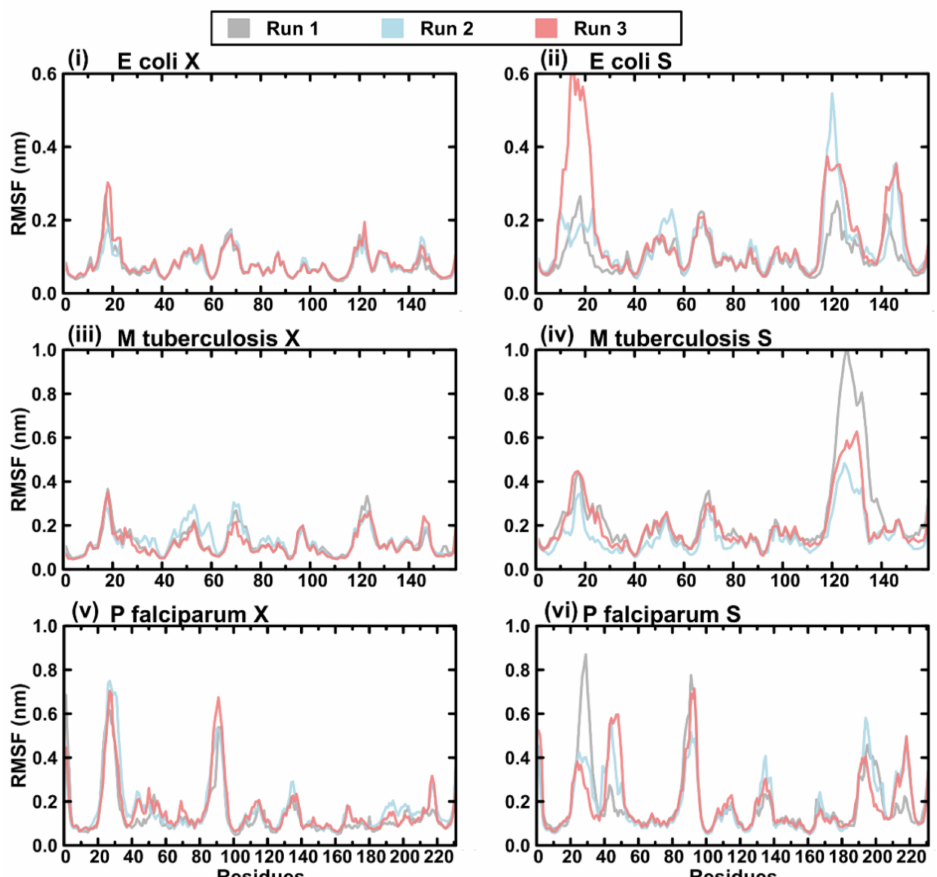
Figure 9. Plots of protein RMSF for the triplicate MD runs: ( i ) the crystal structure models of E. coli , ( ii ) the separated loop models of E. coli , ( iii ) the crystal structure models of M. tuberculosis , ( iv ) the separated loop models of M. tuberculosis , ( v ) the crystal structure models of P. falciparum , and ( vi ) the separated loop models of P. falciparum . Colour key: run 1 (grey), run 2 (blue), and run 3